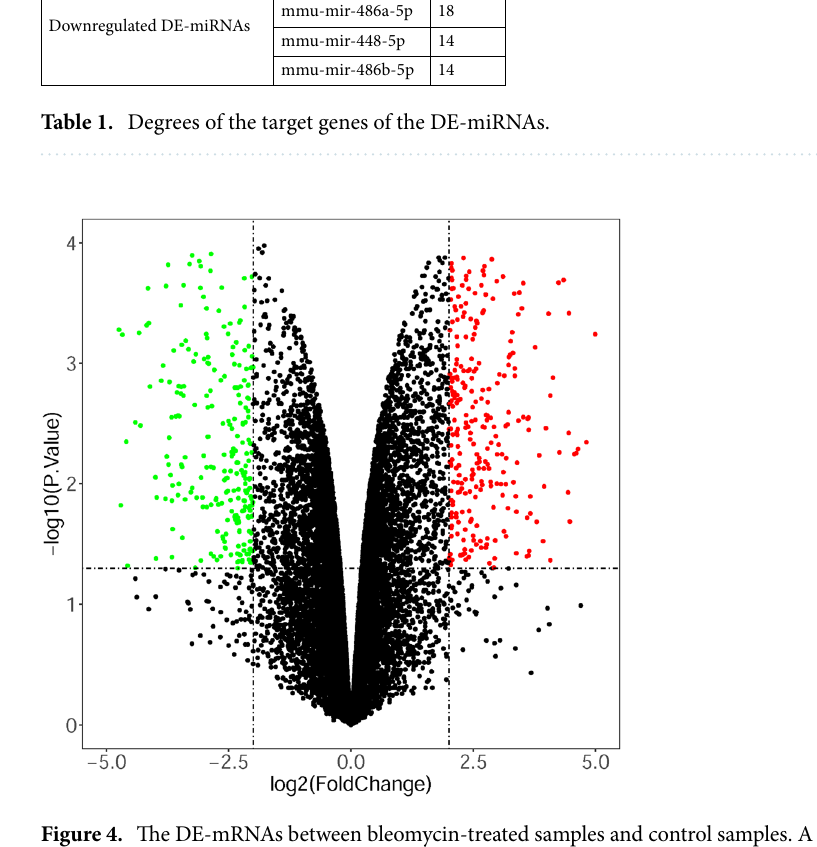
Figure 4. The DE-mRNAs between bleomycin-treated samples and control samples. A |log2FC|> 2 and P < 0.05 were set as the thresholds for identifying DE-mRNAs. The red and green dots represent the upregulated and downregulated mRNAs in the bleomycin-treated samples, respectively; the black dots represent mRNAs that were not differentially expressed between the two